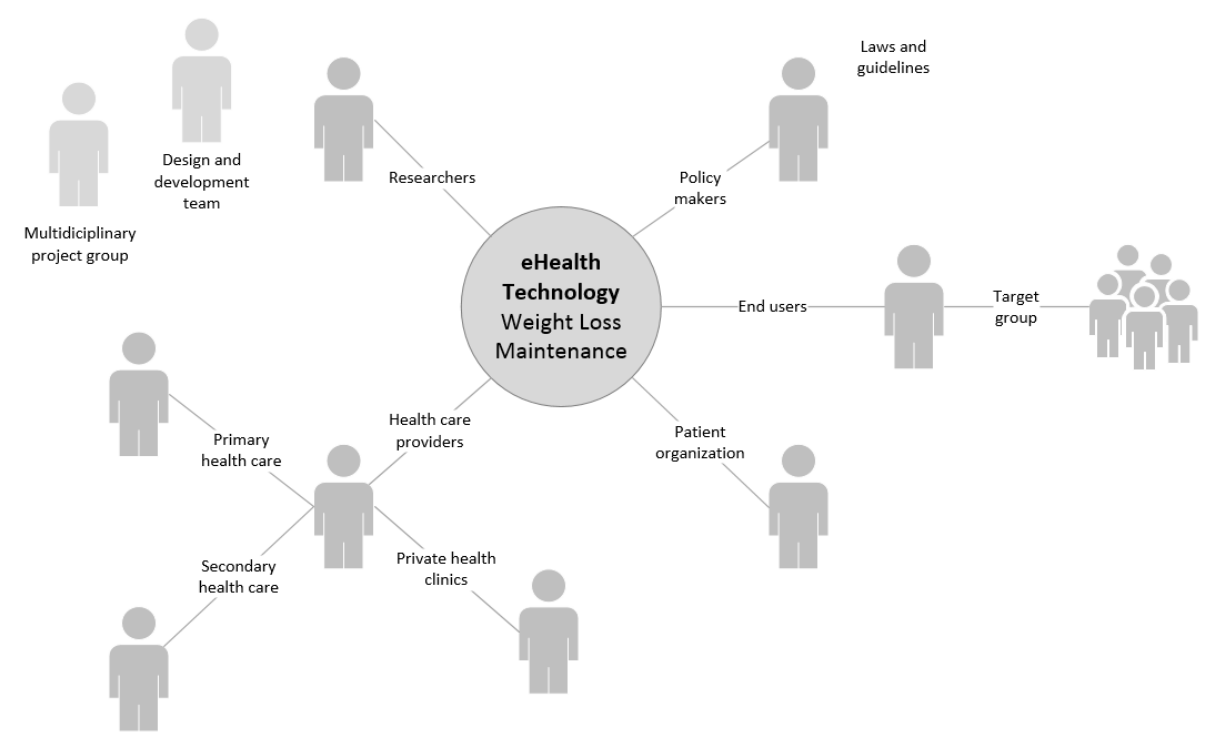
Figure 4. Key stakeholder